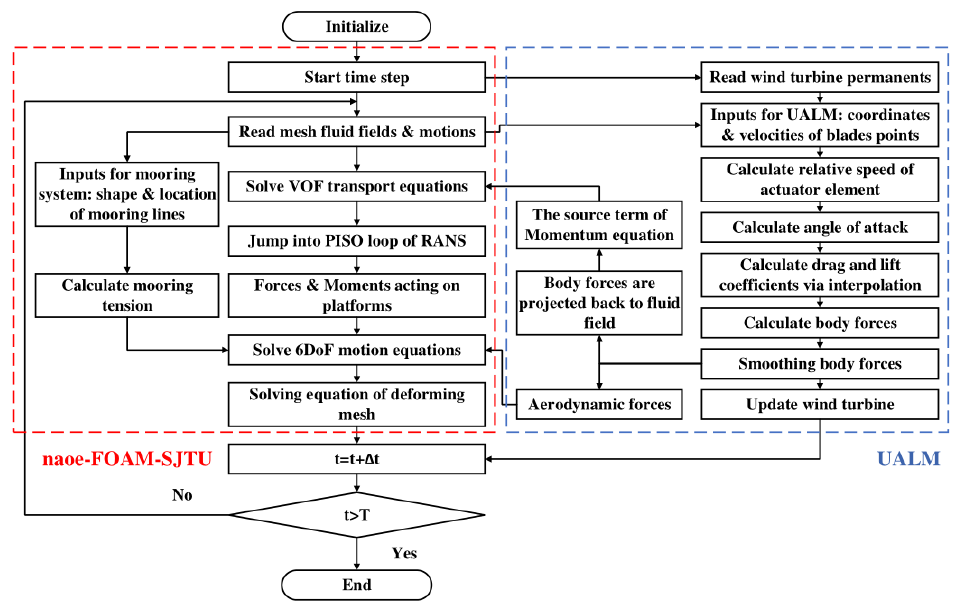
Figure 15. The implement of the unsteady AL to the in-house CFD solver naoe-FOAM-SJTU [145].